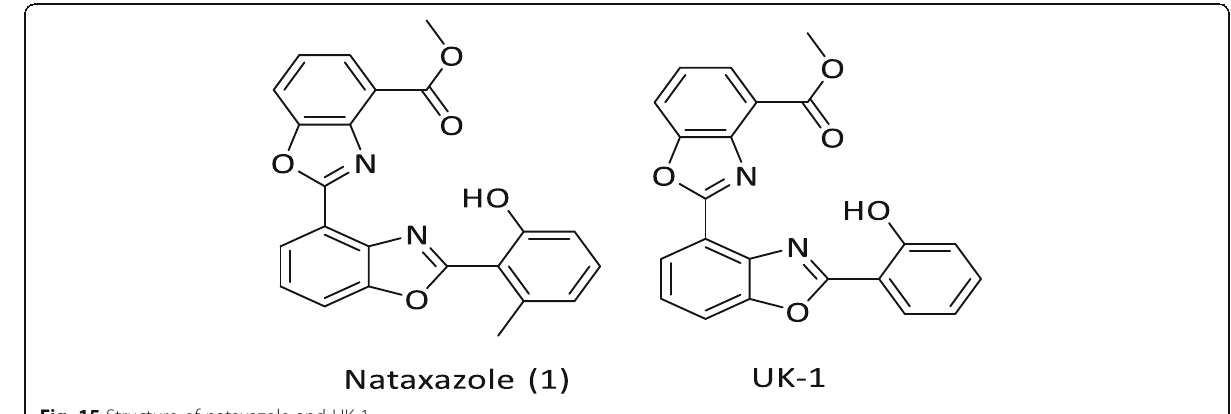
Fig. 15 Structure of nataxazole and